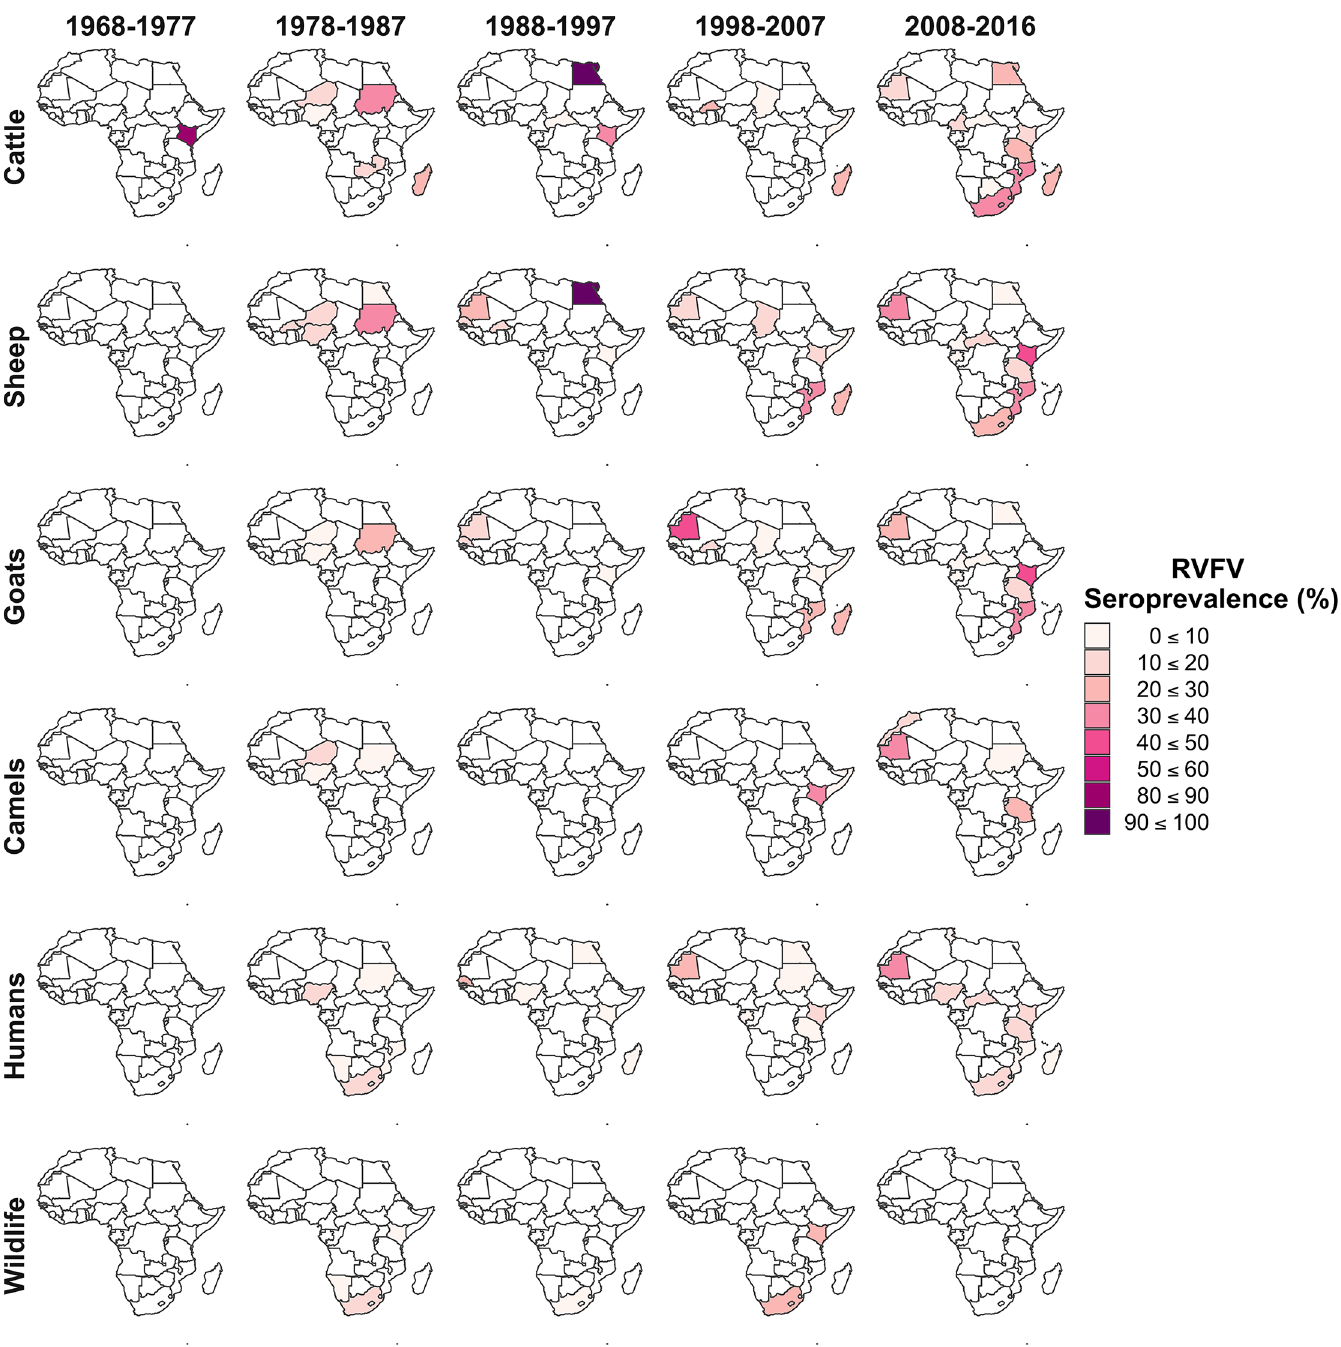
Fig 4. The distribution of seroprevalence (% individuals seropositive) for Rift Valley fever virus by species and decade in African countries, 1968–2016 (year study was conducted).